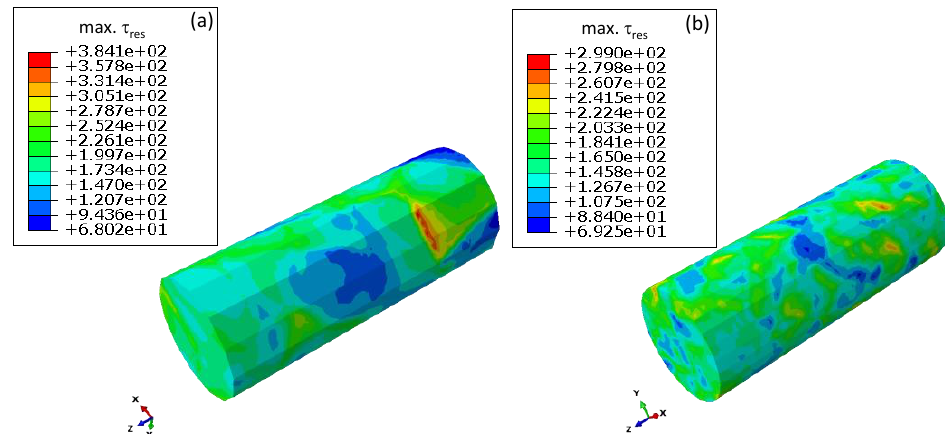
Figure 14. Distribution of the maximum shear stress within the slip system for smooth specimen with coarse-grain material (49 grains, ( a )) and fine-grained textured material (500 grains, ( b